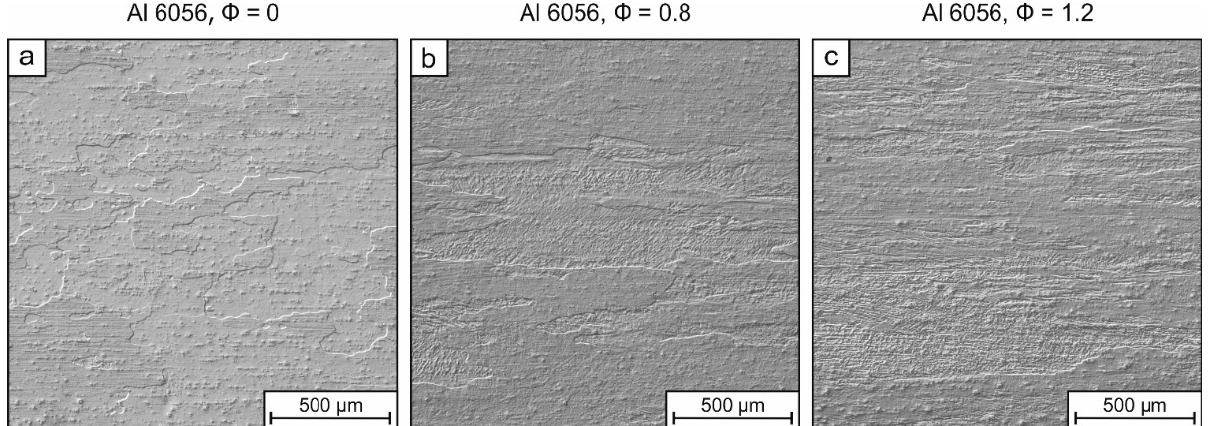
Figure 5. Optical micrographs of the 6056 aluminum alloy in the naturally-aged condition: ( a ) without previous plastic deformation and ( b , c ) after further linear extrusion with induced strains of ( b ) φ = 0.8 and ( c ) φ = 1.2. Because of the linear extrusion, the grains are highly elongated. This effect is more pronounced for the sample with the higher induced strain.